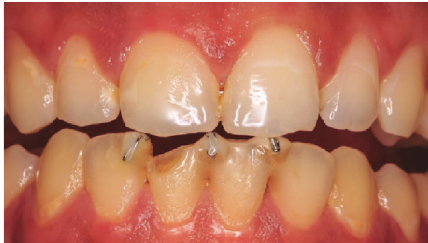
Figure 7: Intraoral view of the bonded appliance interfering and shifting out the nail biting contact position assumed by the patient.